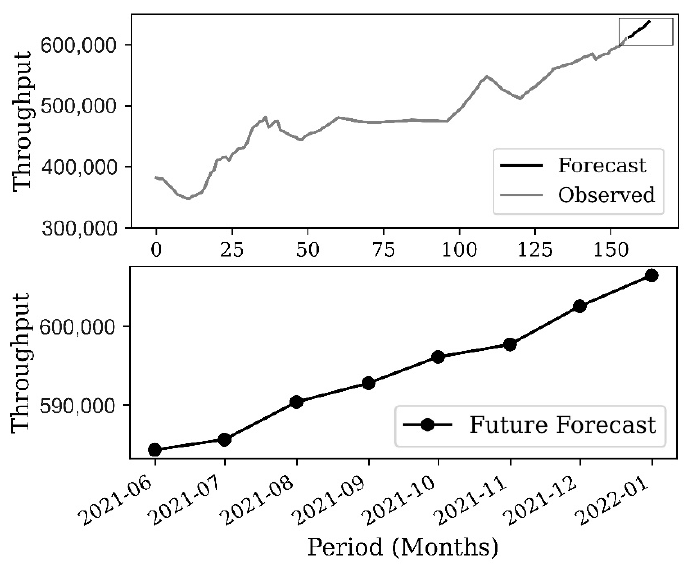
Figure 8. Future forecast of container throughput (CT) for the port of Douala (source: author). Table 3. Monthly future forecast indices of container throuput (CT) based on the RF model.